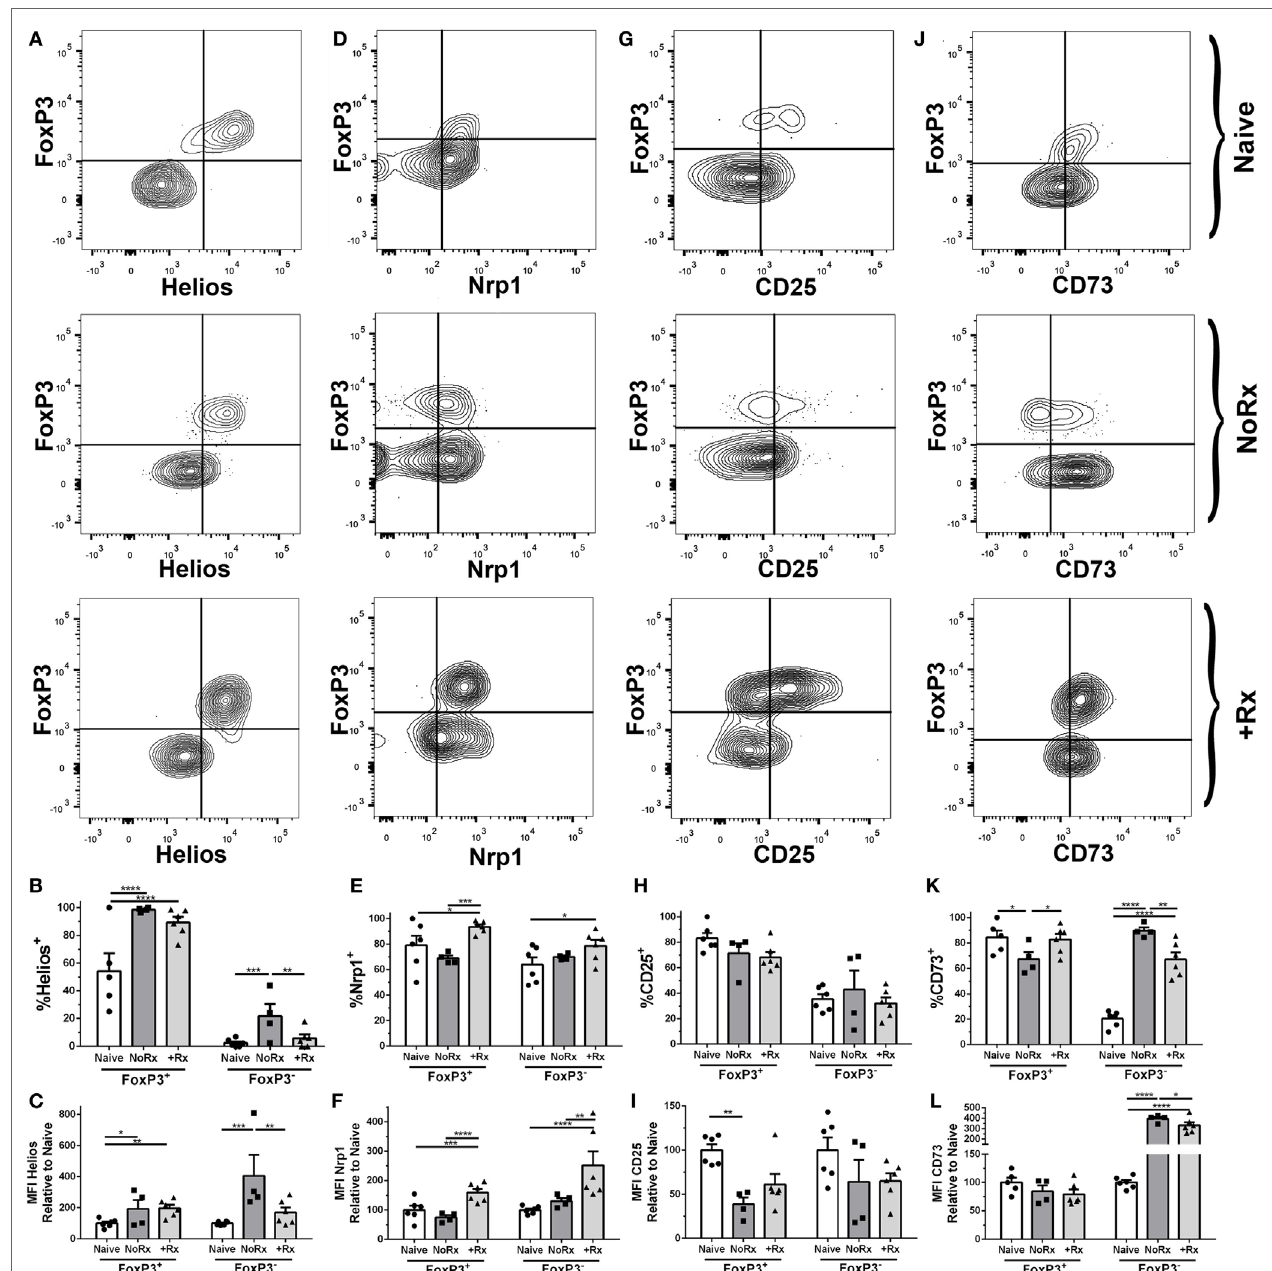
FigUre 6 | Phenotypic analysis of donor-specific 2W:I-A b regulatory T cells (Tregs) isolated from recipients with rejecting and tolerant allografts at day 7 post- transplantation. C57BL/6 recipients transplanted with heterotopic heart allografts from Act.2W-OVA + BALB/c × C57BL/6 F1 donors, were untreated (No Rx) or treated with α CD154/DST, and sacrificed on day 7 post-transplantation. Sample gating strategies (a,D,g,J) , percentage of cells positive (B,e,h,K) , and mean fluorescent intensity (c,F,i,l) relative to naïve 2W:I-A b -specific FoxP3 + or FoxP3 − cells of (a–c) , Helios; (D–F) , Neuropilin-1; (g–i) , CD25; and (h–l) , CD73; in naïve, acutely rejecting (No Rx), and α CD154/DST-treated ( + Rx) animals. * p < 0.05, ** p < 0.01, *** p < 0.001, **** p < 0.0001 by two-way ANOVA. Mean ± SEM is shown, and each point represents one animal from three replicate experiments ( n =